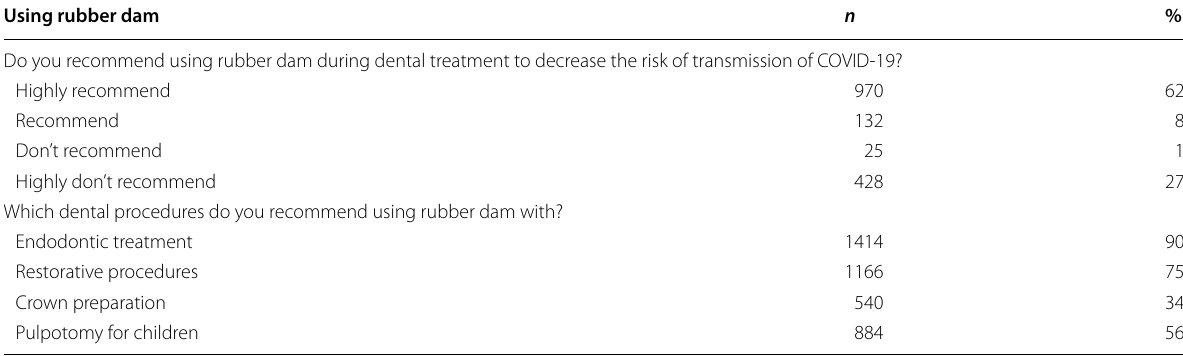
Table 2 Frequencies ( n ) and percentages (%) for answers regarding the use of rubber dam Using rubber dam n